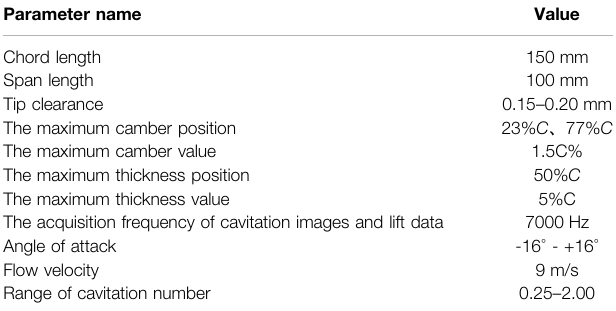
TABLE 1 | The parameters of the cavitation tunnel and the